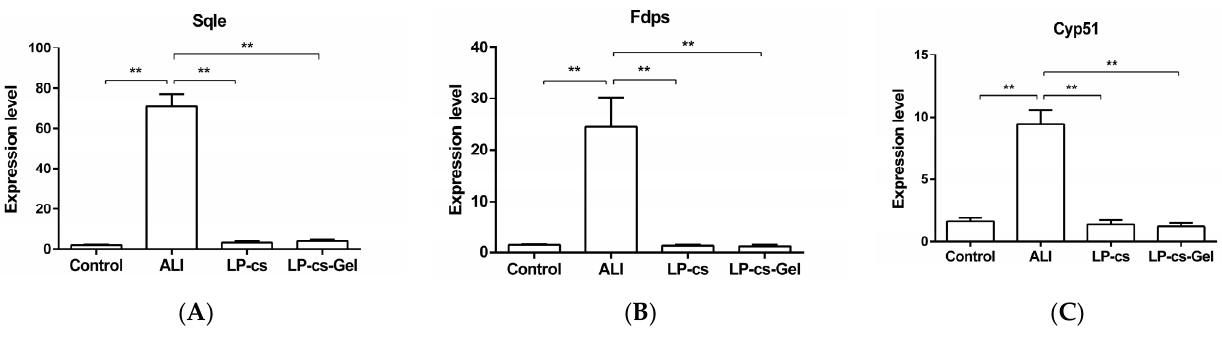
Figure 7. Expression levels of the genes involved in cholesterol metabolism by qPCR: ( A – C ) The expression levels of Sqle , Msmo1, and Cpy51 as compared wit GAPDH expression in each group. Sqle , squalene epoxidase; Msmo1 , methylsterol monooxygenase 1; Cyp51 , cytochrome P450 family 51 subfamily. Data are presented as the mean ± SEM for each group, with n = 6 per group. p -values were determined by one-way ANOVA. ** p < 0.01.